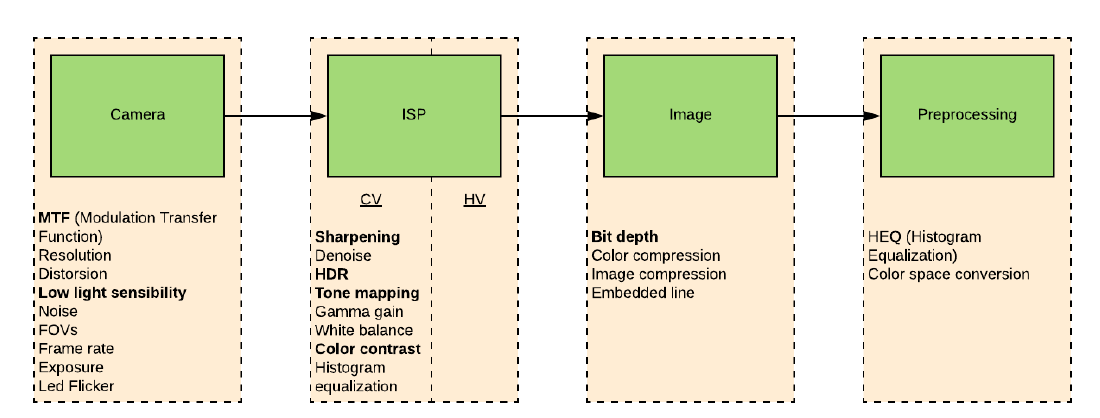
Figure 7. Pipeline overview. Key ISP modules which impact CV performance are marked in